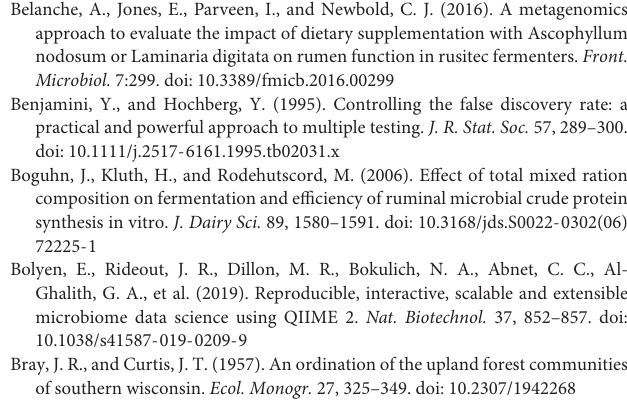
Supplementary Figure 1 | Alpha diversity indices by treatment, sample-type and day of sampling. Faith’s phylogenetic diversity and Shannon entropy index are plotted for archaea and bacteria. Each subplots represents one of alpha diversity metrics at a certain day of sampling. Boxplots visualize alpha diversity metrics distribution across all treatments inside of a certain group. Kruskal–Wallis H -test was performed to test the differences between treatments alpha diversity and corresponding P -values are plotted on the top of subplots. Significant P -values denoted as ‘*’ if P ≤ 0.05. Supplementary Figure 2 | SCNIC based correlations of microbial relative abundances among effluent, fermenter liquid and feed residue sample types with total gas production, methane as a percentage of total gas [CH4(%)], ammonium nitrogen in effluent (NH 3 -N), VFA production and acetate to propionate ratio (A:P ratio). Only correlation coeffitients ( r ) with absolute values ≥ 0.3 and adjusted P -values ≤ 0.05 are plotted. Positive correlations are colored in read and